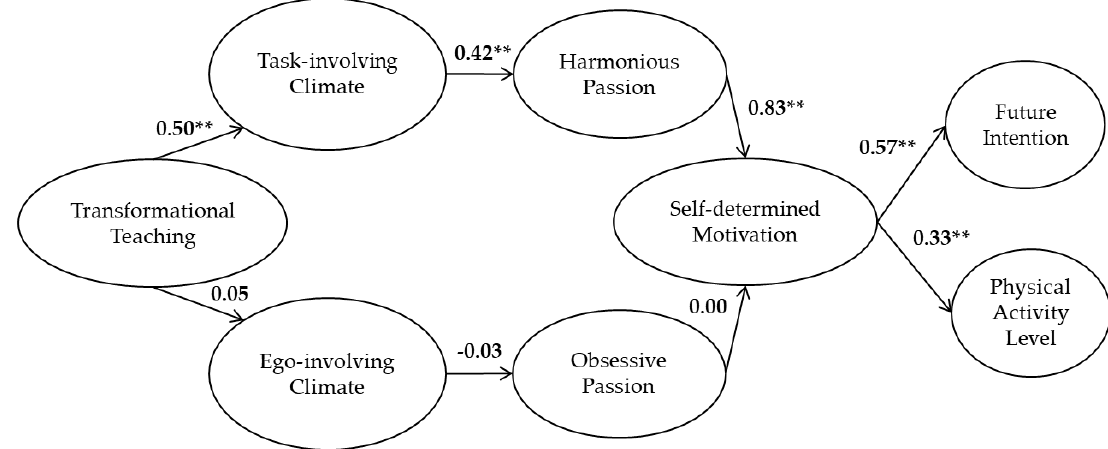
Figure 2. The structural model of the interrelationships between PE students’ perceptions of the social environment, passion, self-determined motivation, future intention and physical activity level. All coe ffi cients are standardized. Factor indicators are not represented for reasons of simplicity of presentation. The correlation between the error of the indicators of harmonious and obsessive passions (r = 0.61) are not shown. ** p <